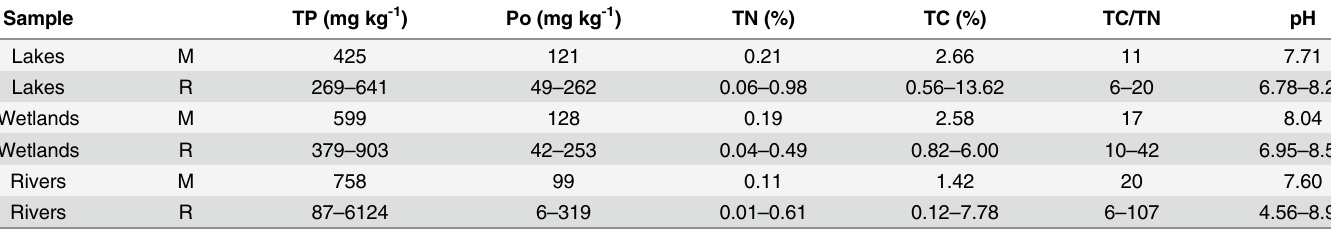
Table 1. Sediment characteristics in different freshwater ecosystems in Eastern